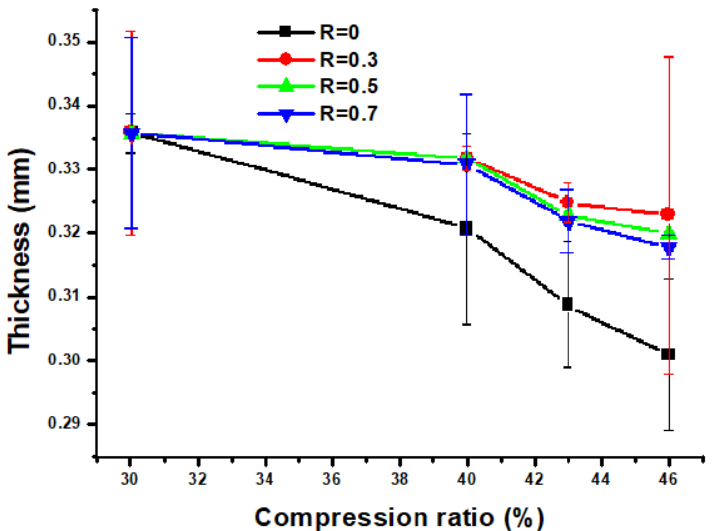
Figure 5. Influence of compression ratio and fillet radius on the thickness of MEA.